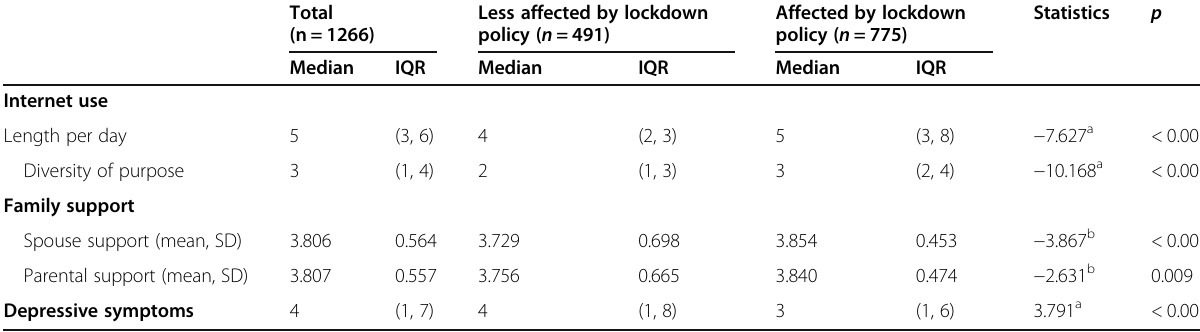
Table 2 Internet use, family support and depressive symptoms in different